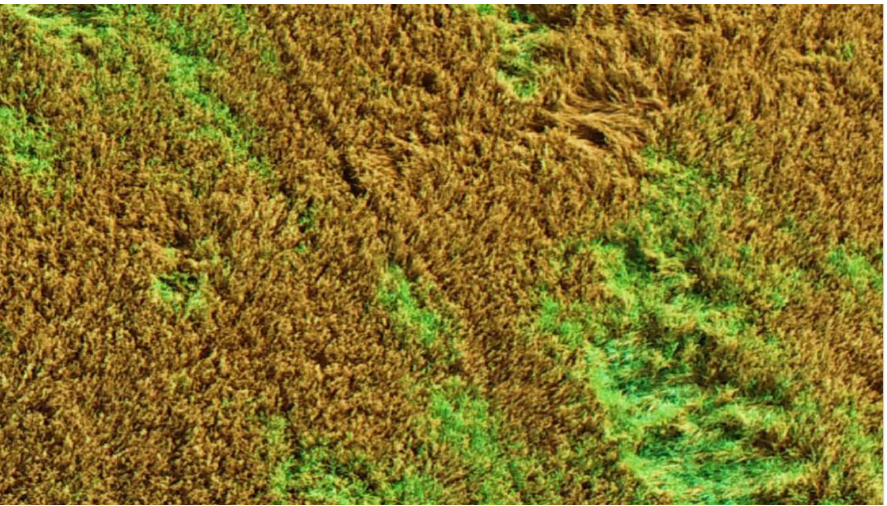
Figure 6. Green couch grass ( Elymus repens ) spots on a ripening wheat field in an UAV image from Jokioinen,